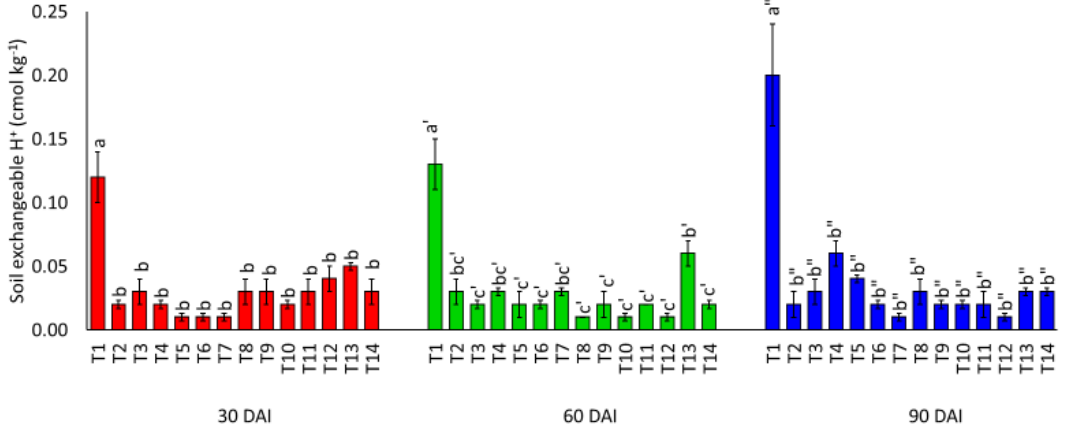
Figure 7. Effects of treatments on soil exchangeable hydrogen ions after thirty, sixty, and ninety days of incubation, where T1: soil alone, T2: Egypt rock phosphate alone, T3: Egypt rock phosphate + 100% charcoal, T4: Egypt rock phosphate + 100% sago bark ash, and T5: Egypt rock phosphate +